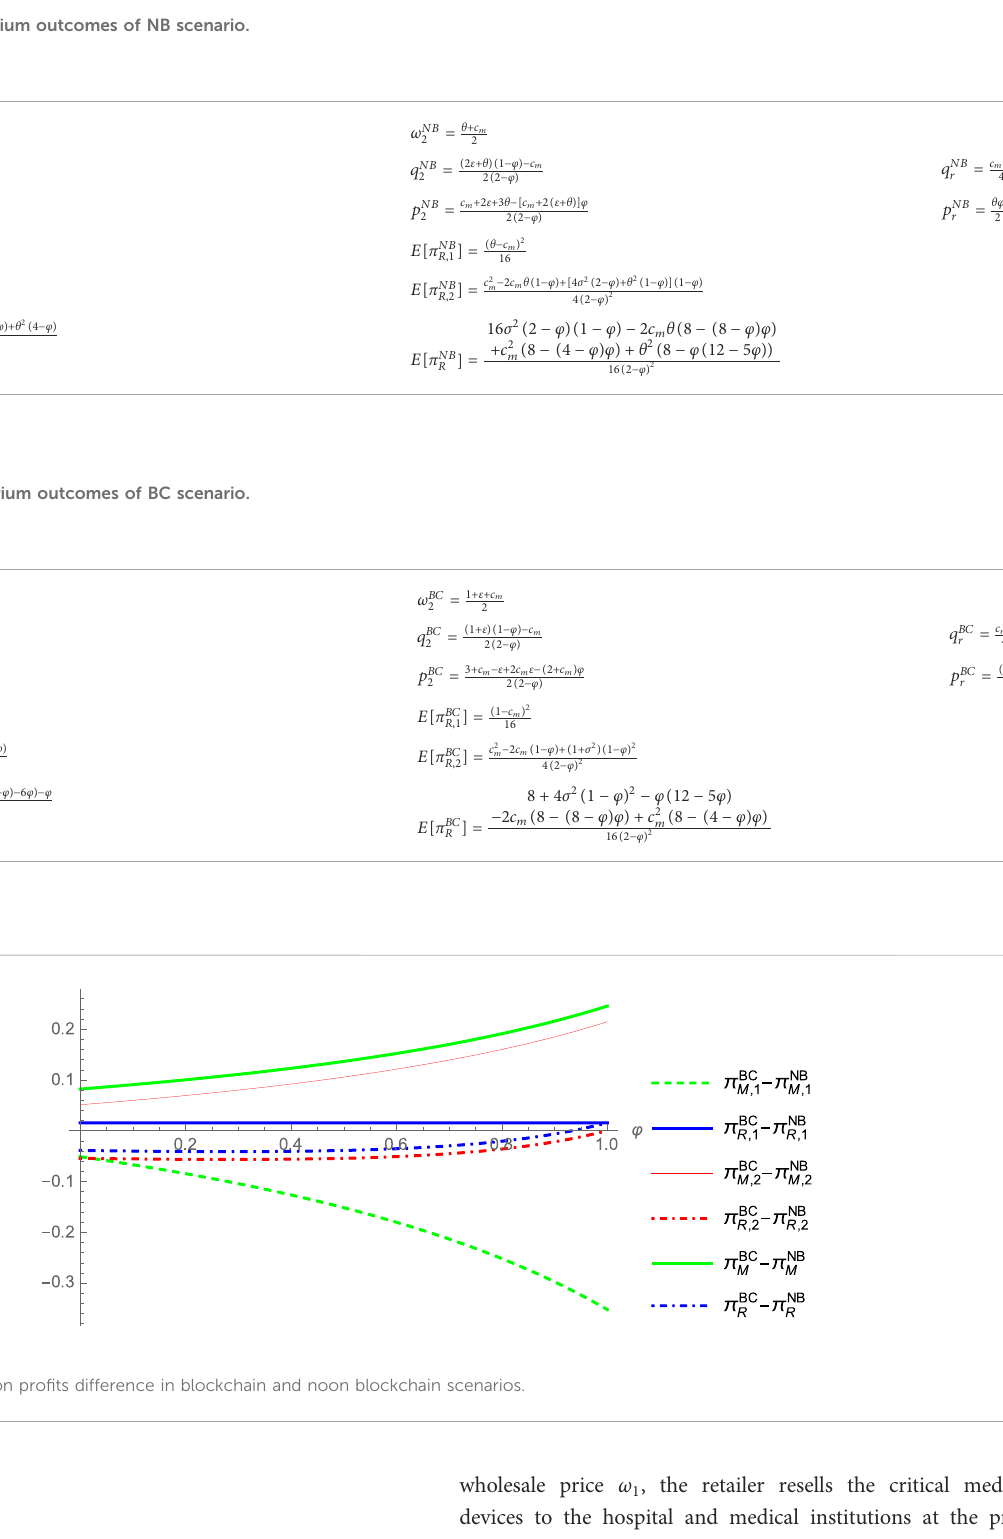
TABLE 1 The equilibrium outcomes of NB scenario.